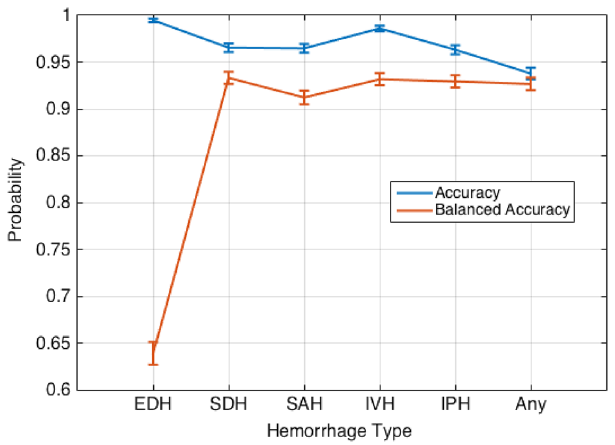
Figure 3. Probability estimates and 95% confidence intervals of hemorrhage types with respect to the accuracy and balanced accuracy